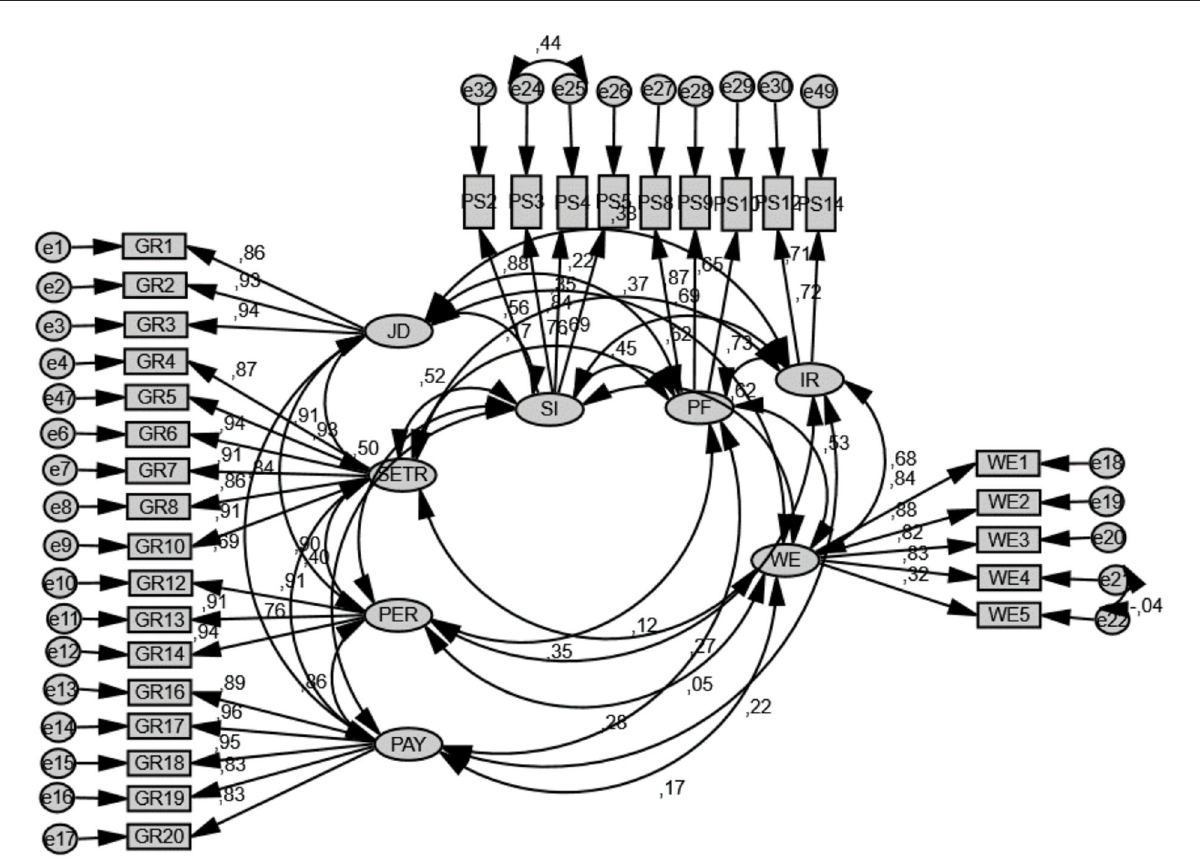
FIGURE2 The confirmatory analyses model. JD, Job design; STR, Selection and training; PER, Performance; PAY, Wage management; SI, Self identity; PF, Protective focus; IR, Internal responsibility; WE, Work engagement.